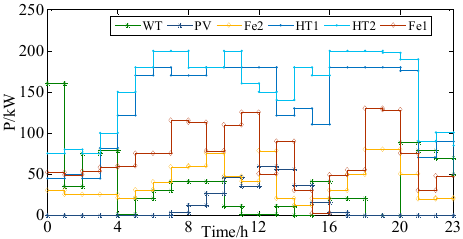
Figure 11. The predicted output of DGs.